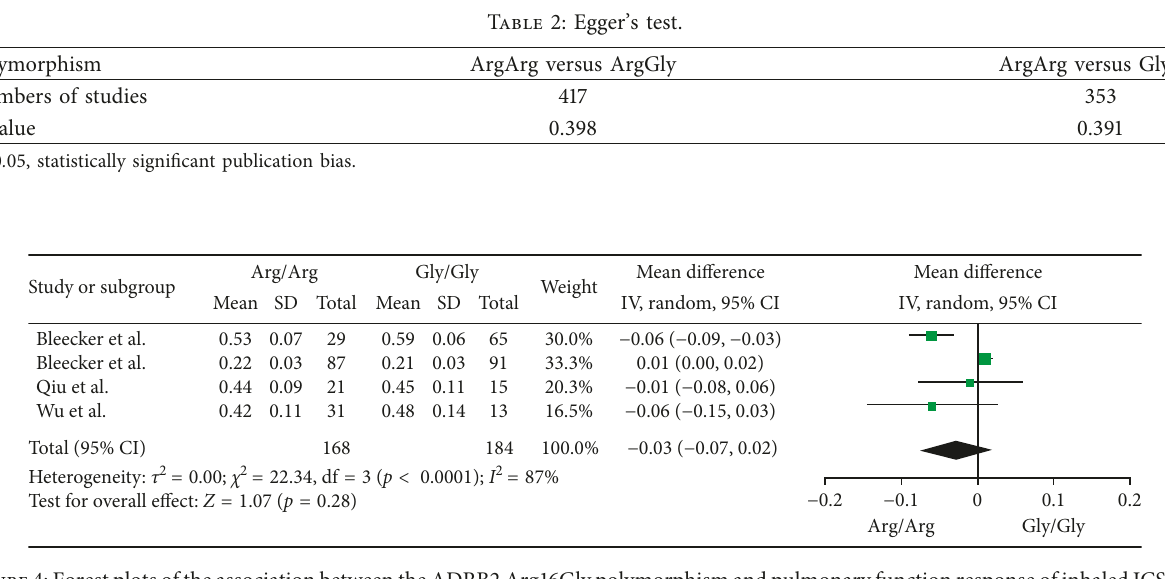
Figure 4: Forest plots of the association between the ADRB2 Arg16Gly polymorphism and pulmonary function response of inhaled ICS plus LABAs for asthma treatment (Arg/Arg or Gly/Gly) with 4 studies